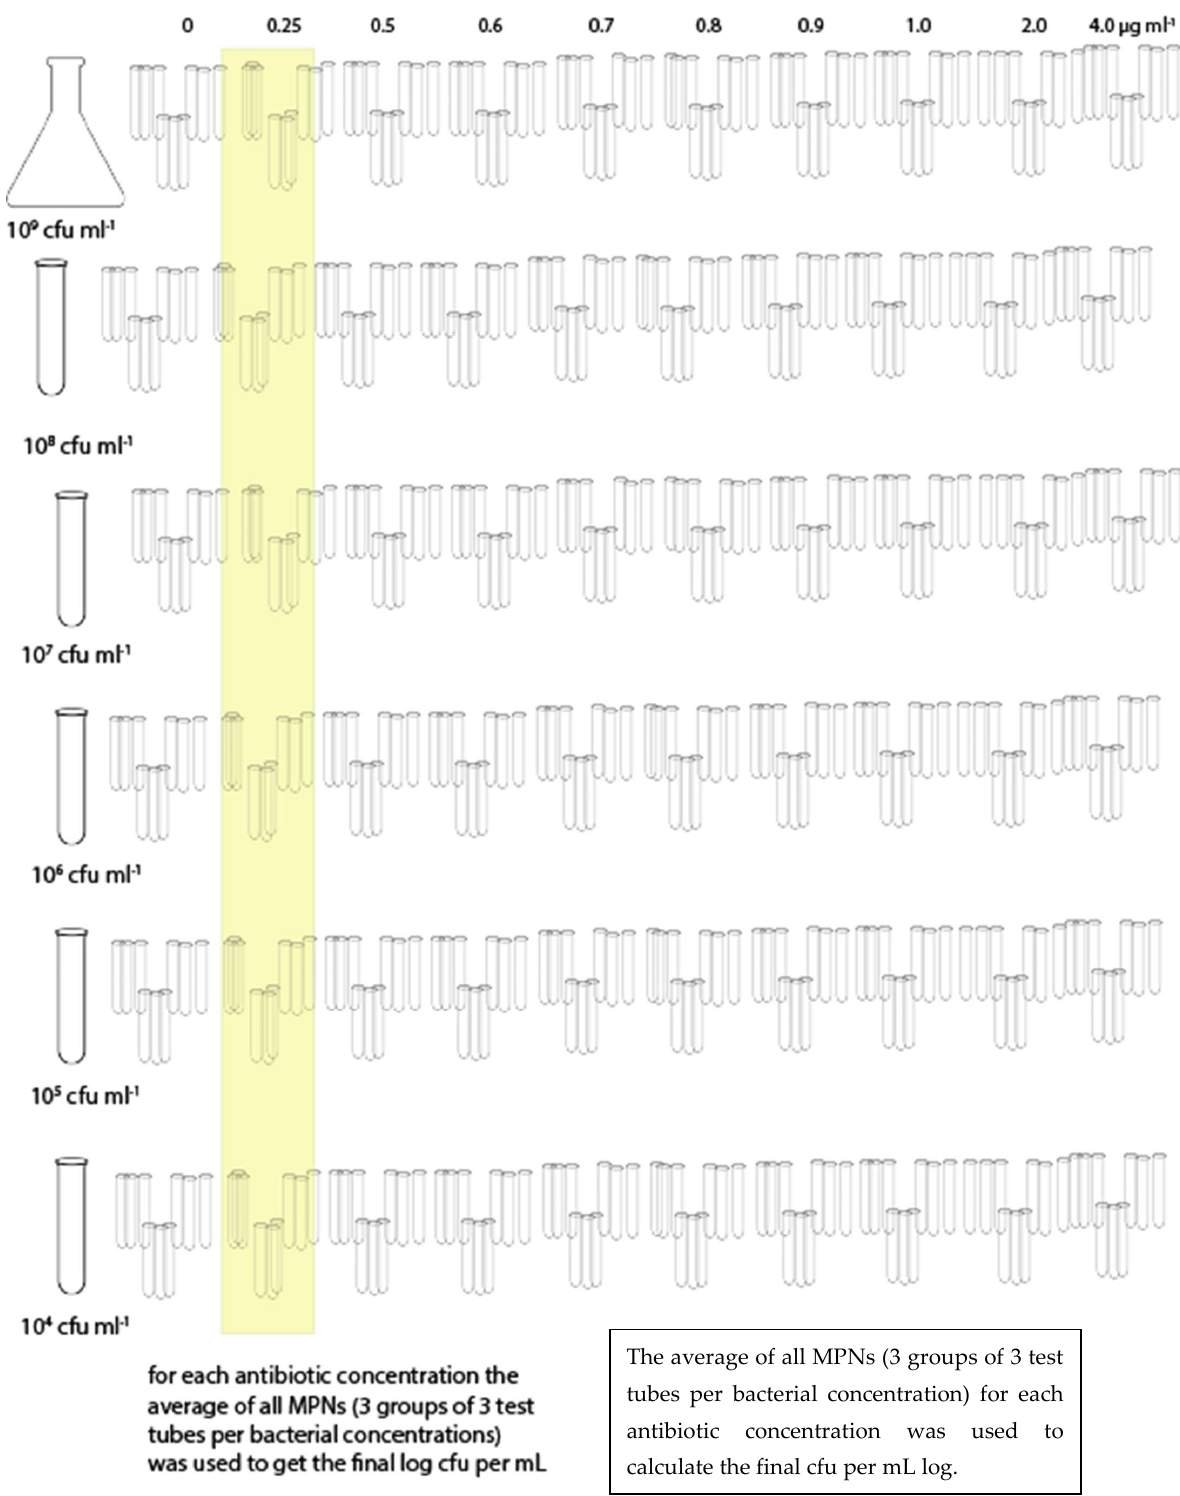
Figure 1. Sampling scheme for BHI.